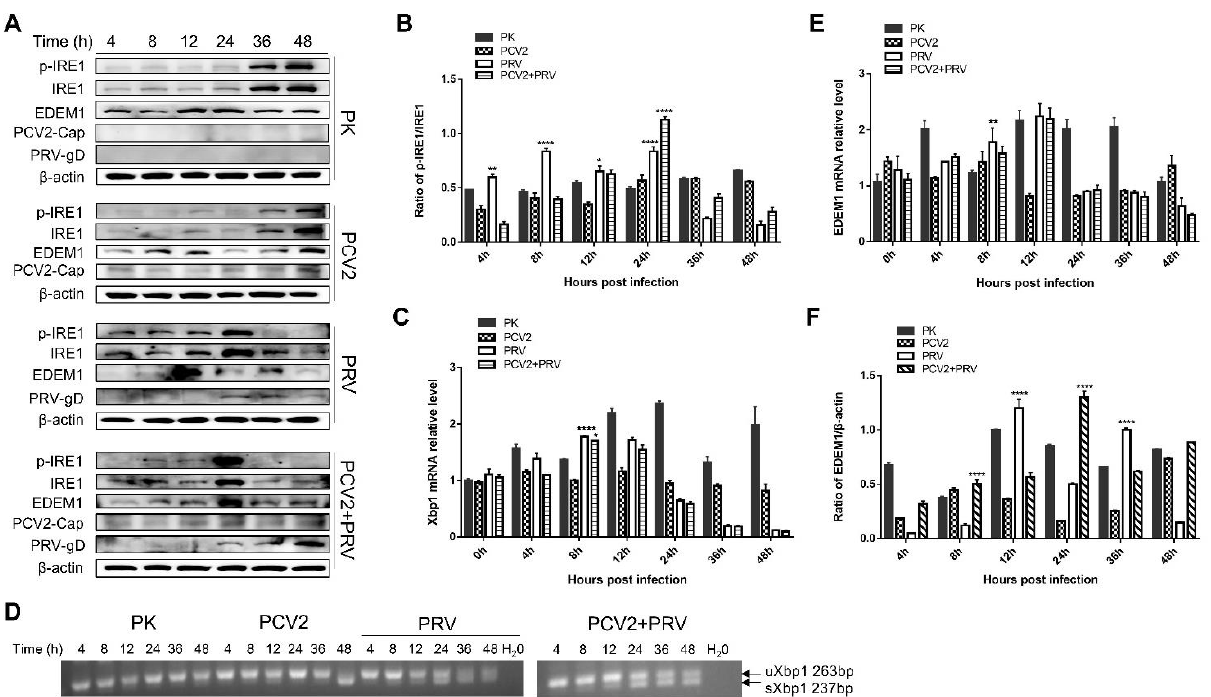
Figure 6. IRE1 pathway was activated in PRV single- and coinfection groups. PK-15 cells were single- or co-infected with PCV2 and/or PRV for 4, 8, 12, 24, 36, and 48 h. *, p -value < 0.05; **, p -value < 0.01; ****, p -value < 0.0001. ( A ) Western blotting of p-IRE1, IRE1, EDEM1, and viral proteins PCV2 Cap and PRV gD. β -actin was used as a control. ( B ) The ratio of p- IRE1α and IRE1α. Quantification of the bands corresponding to the p- IRE1α and IRE1α by densitometry was normalized to β -actin. ( C ) xbp 1 mRNA levels quantified by real-time RT-PCR. ( D ) Splicing of xbp 1 mRNA. Spliced xbp 1, s xb p1; unspliced xbp 1, u xbp 1. ( E ) EDEM1 mRNA levels were quantified by real-time RT-PCR. ( F ) The relative amount of EDEM1 to β -actin was quantified by densitometry analysis using the ImageJ software. Phospho-IRE1 (Ser724) (Affinity, Jiangsu, China, 1:1000), IRE1 (Affinity, Jiangsu, China, 1:1000), EDEM1 (Affinity, Jiangsu, China, 1:2000), PRV-gD (Lvdu, Shandong, China, 1:500), PCV2- cap [31] and β -actin (Proteintech, Wuhan, Hubei, China, 1:10,000) were used as primary antibody, respectively. Unprocessed original images can be found in Supplementary Figures S3 and S4.